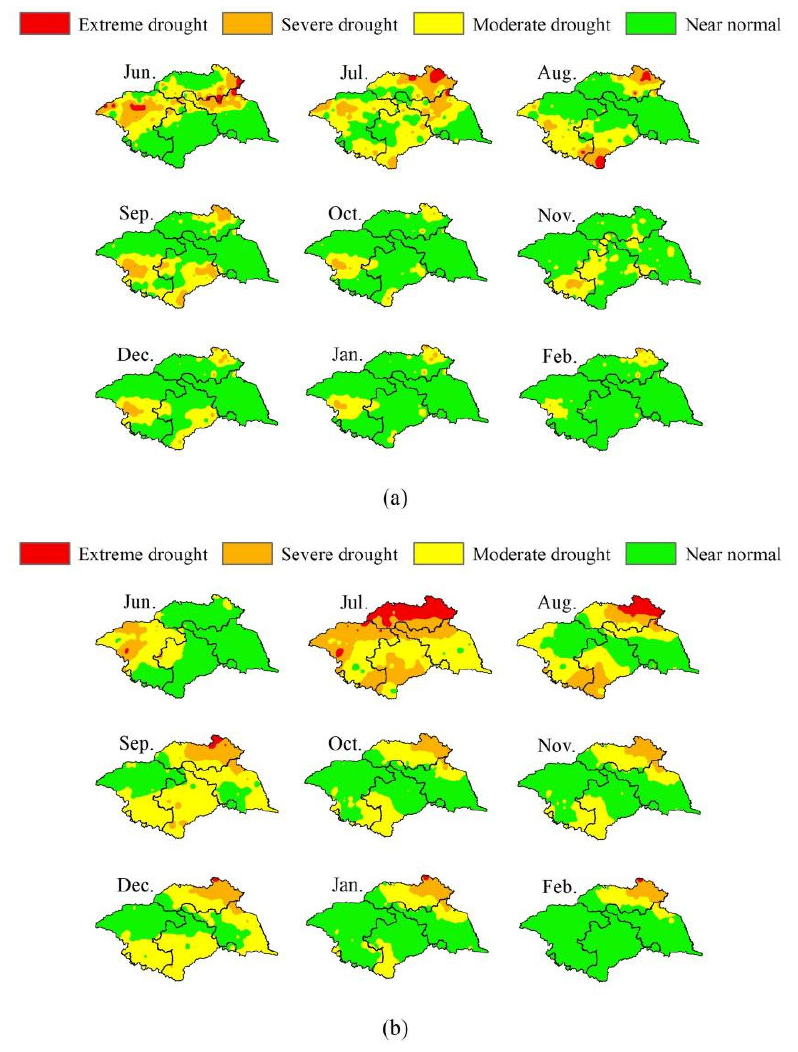
Figure 13. Spatial distribution maps of SPI-12 from ( a ) gauges; and ( b ) PERSIANN-CDR for the 1992 drought event.